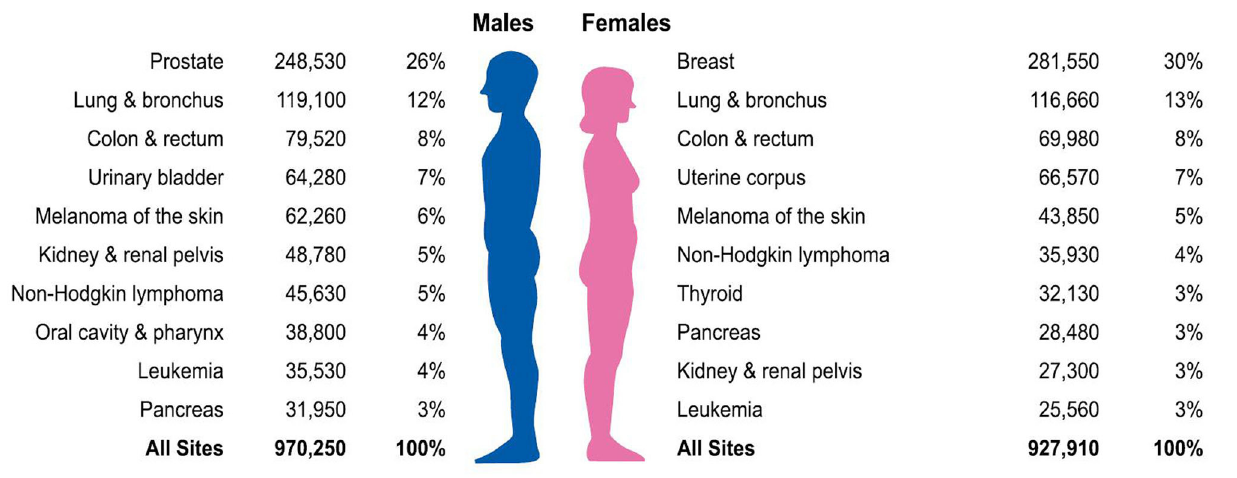
PIR (PIR ≤ 1.0 vs. PIR 1.0–4.0, PIR ≥ 4.0 vs. PIR 1.0–4.0); Model 2 adjusted for model 1 variables plus an additional adjustment for BMI (25.0–29.9 vs. < 25.0, ≥ 30.0 vs. < 25.0), drinking status (<2 drinks/d vs. non-drinker, ≥ 2 drinks/d vs. non-drinker),